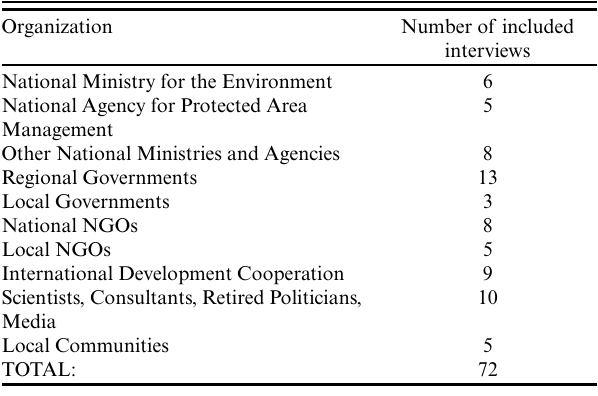
Table 1 . List of included interviews separated by represented organisation or the